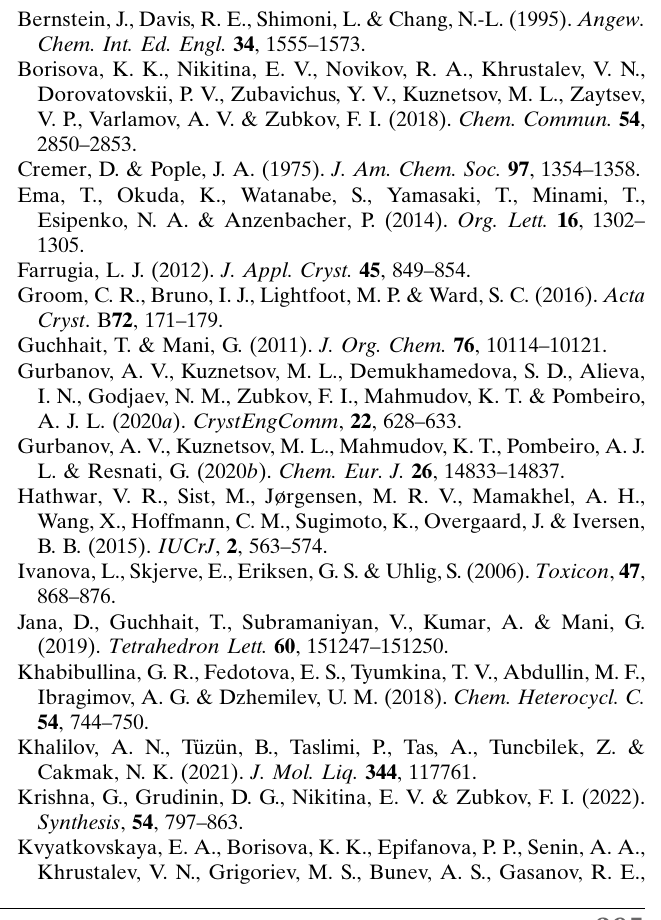
conformation from the title compound: the furan rings in the title compound are almost normal to the mean plane of the main twelve-membered difuryl-containing ring and their oxygen atoms are oriented to the opposite sides whereas in NOYCOW, they are also almost normal, but are on the same side.